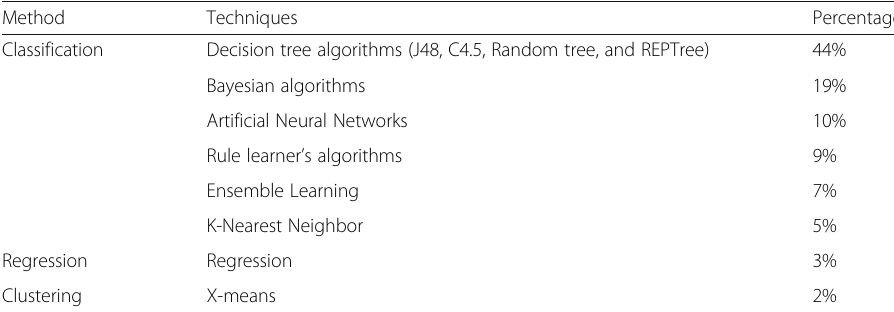
Table 13 recurrence of algorithms by categories